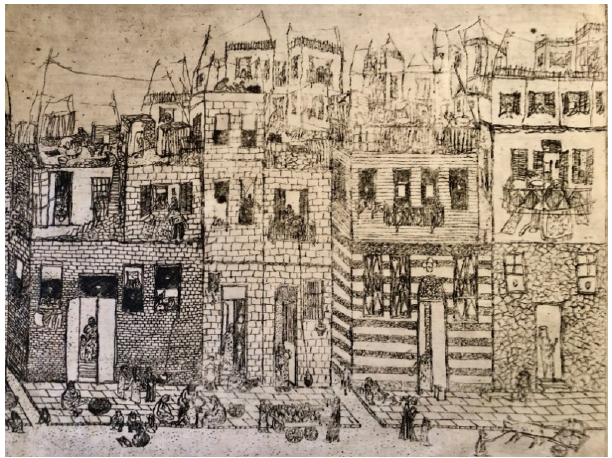
Figure 12. Menhat Helmy, Old Cairo (circa 1957). Etching. Source: Menhat Helmy family archive and also republished in Videkani ć (2019).